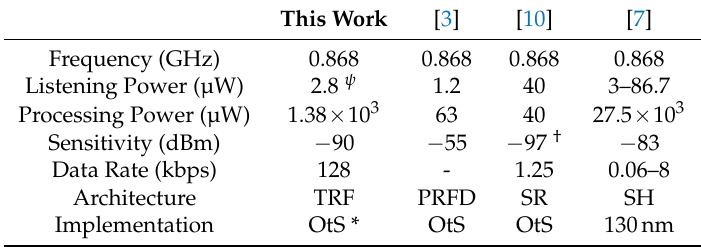
WuRx prototypes comparison. super-regenerative; SH,